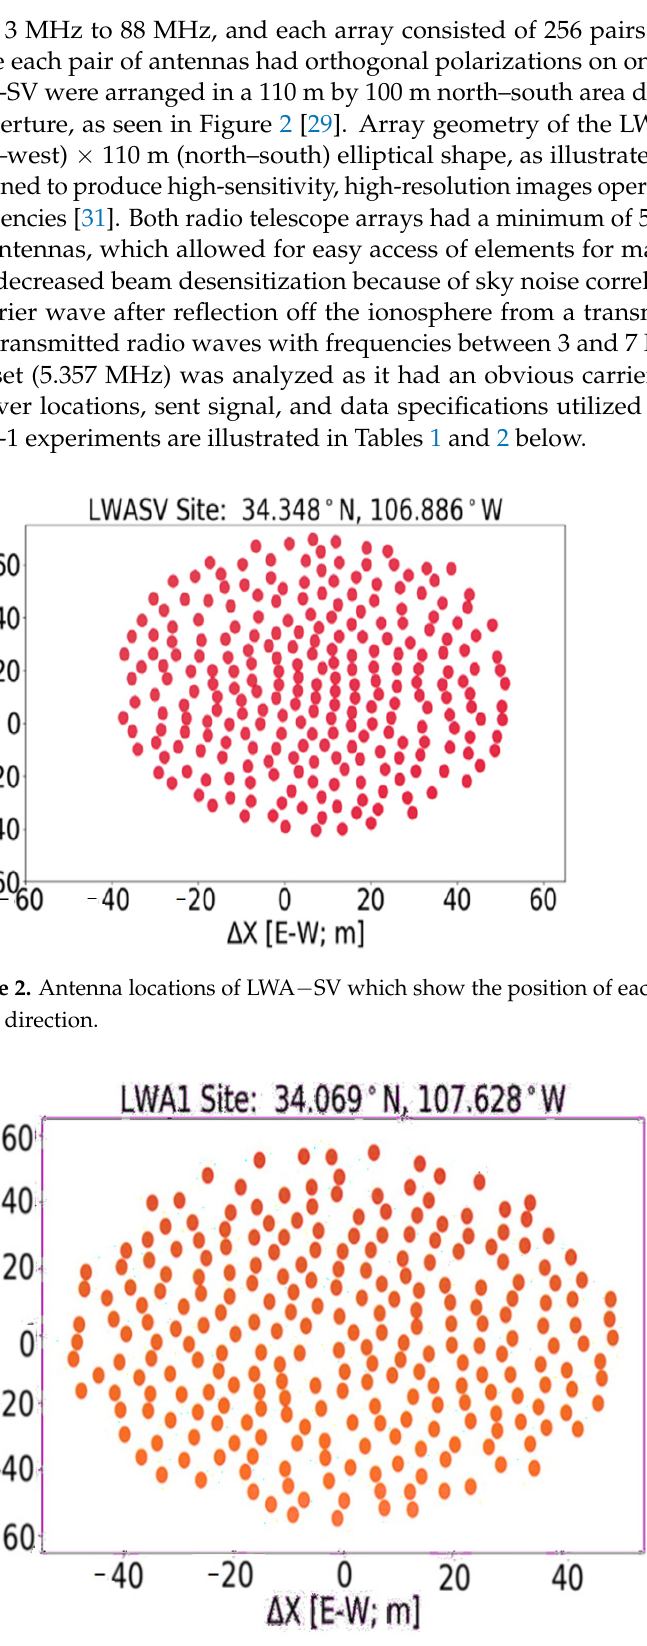
Figure 3. Antenna locations of LWA −1 present the position of each antenna as a red circle in x and y direction. Table 1. Transmitter signal and data set specifications used during the LWA-SV experiment.